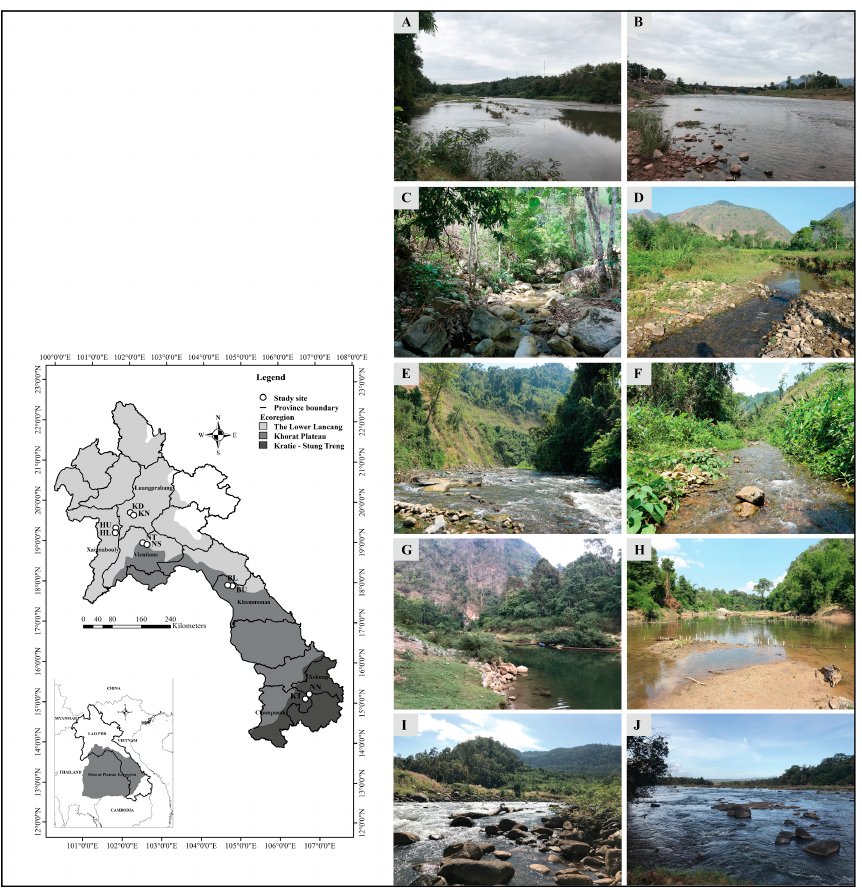
Figure 1. Map showing the distribution of the 10 study localities (wadeable rivers and streams) in Lao PDR. Photographs of 10 study localities. ( A ) Nam Houng upstream (HU), ( B ) Nam Houng downstream (HL), ( C ) Nam Khod (KD), ( D ) Nam Khan (KN), ( E ) Nam Song (NS), ( F ) Nam Thang (NT), ( G ) Nam Hinboun upstream (BU), ( H ) Nam Hinboun downstream (BL), ( I ) Xe Katam (KT), ( J ) Xe Namnoy (NN). Table 1. General characteristics and geographical position of 10 localities of wadeable rivers and streams conduced in this study in Lao PDR.